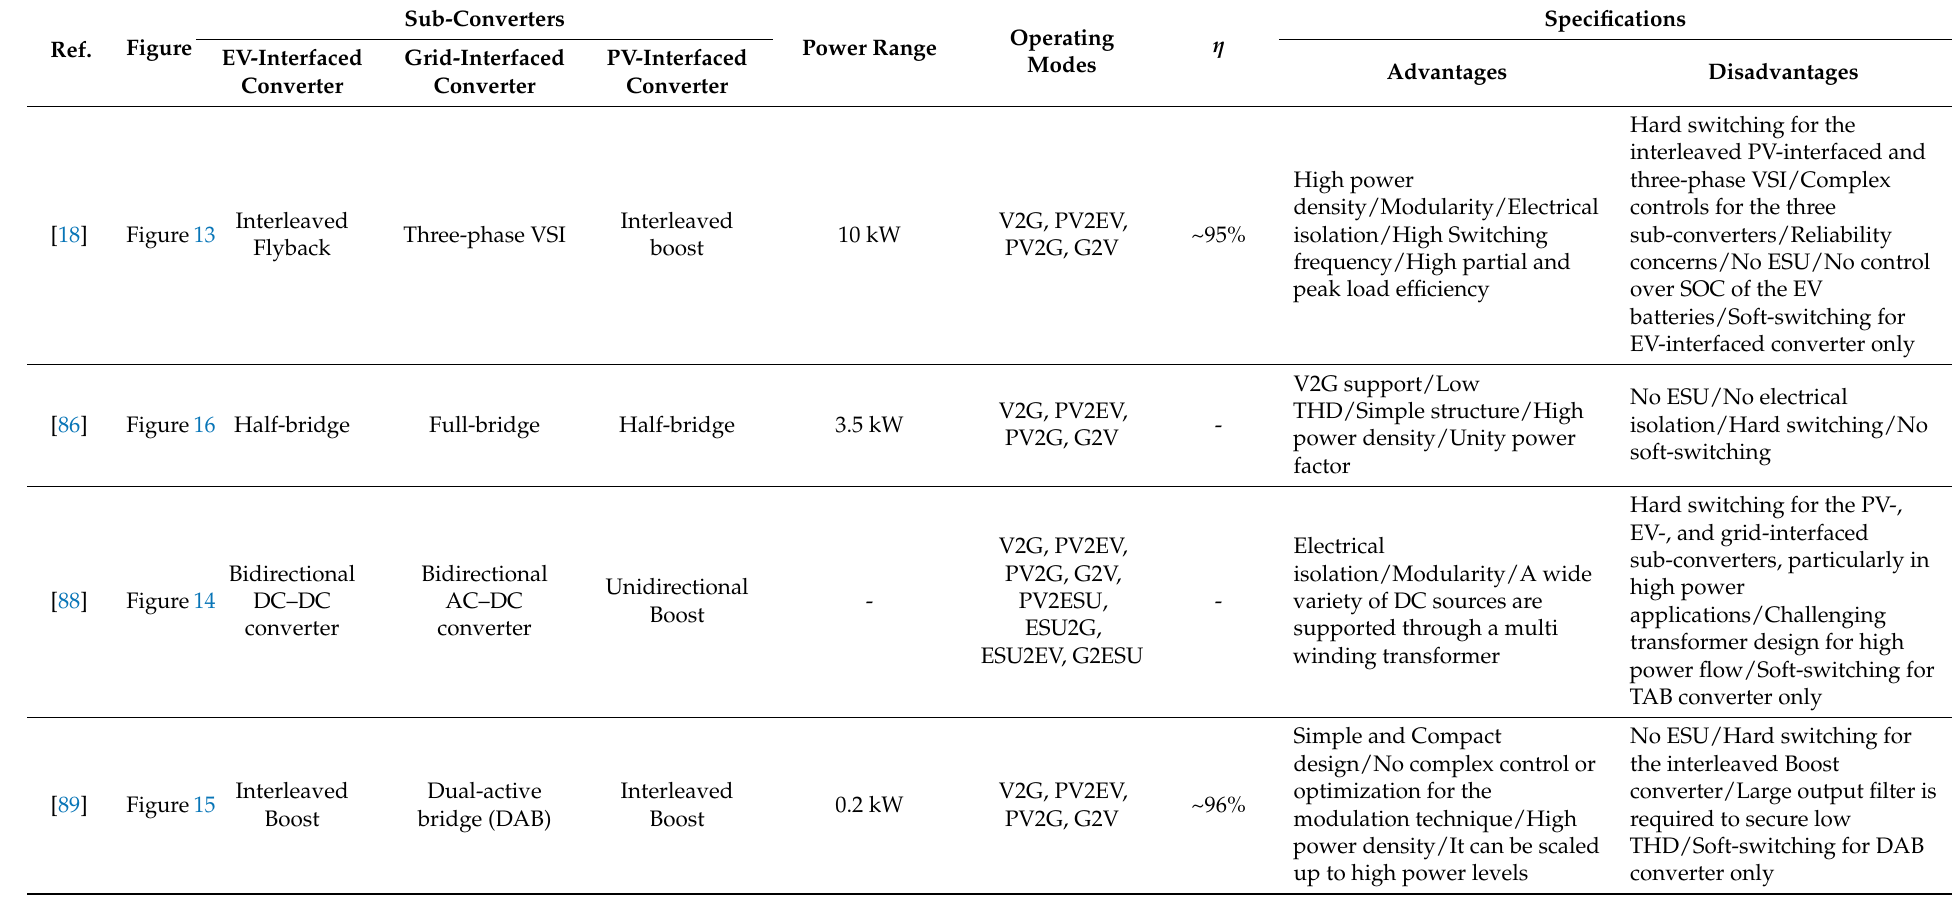
Table 5. A technical comparison between integrated